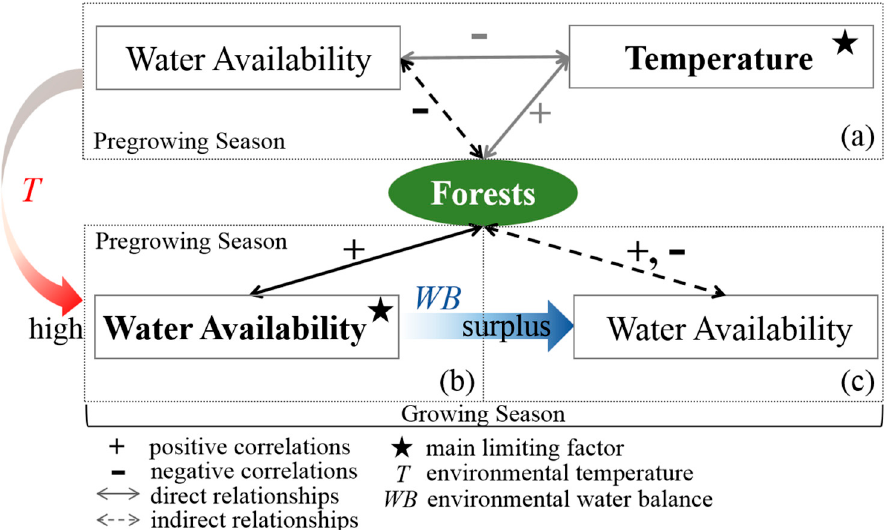
Figure 13. The underlying mechanism for the positive or negative role of water availability in forest vigor in ( a ) cold regions during the pregrowing season, ( b ) warm regions during the pregrowing season or dry regions during the growing season, and ( c ) wet regions during the growing season. The “ − ” and “+” represent negative and positive correlations, respectively. The star represents the main limiting factor of forest vigor for different seasons. The dotted and solid lines represent indirect and direct relationships between forest vigor and water availability, respectively. The pregrowing season is January–April, and the growing season is May-September, in China. The temperature and water availability are continuous climatic variables; WB and T are the monthly averaged water balance and temperature during 2001–2015, respectively, which characterize the environmental climate of forests.